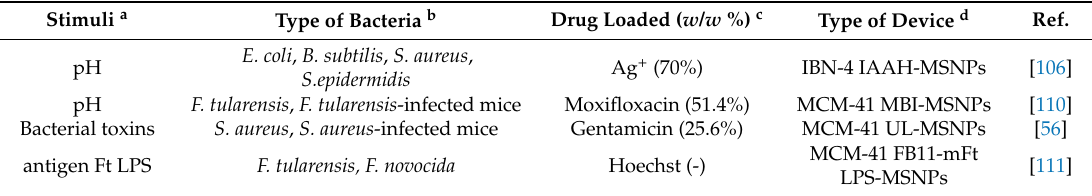
Table 3. Stimuli-Responsive Mesoporous Silica Nanoparticles for the Treatment of Planktonic Bacteria. Stimuli a Type of Bacteria